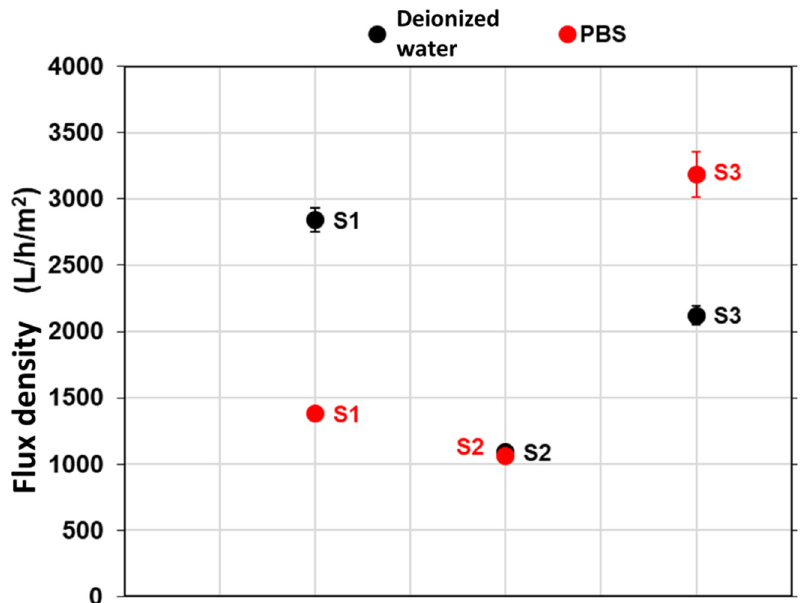
Figure 3. Water and PBS flux densities of the bio-based membranes elaborated.